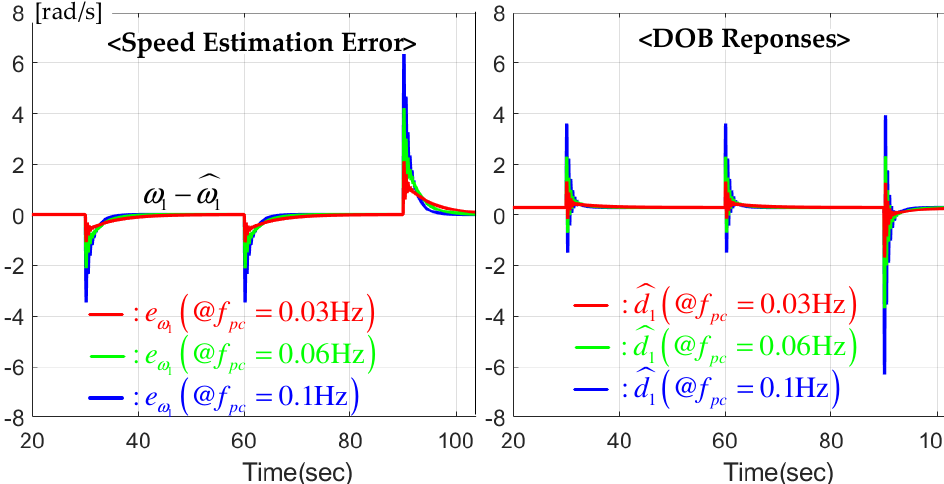
Figure 7. Speed estimation error and DOB.